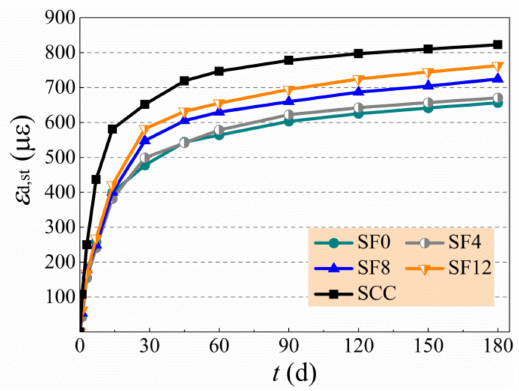
Figure 8. Drying shrinkage of tested specimens.